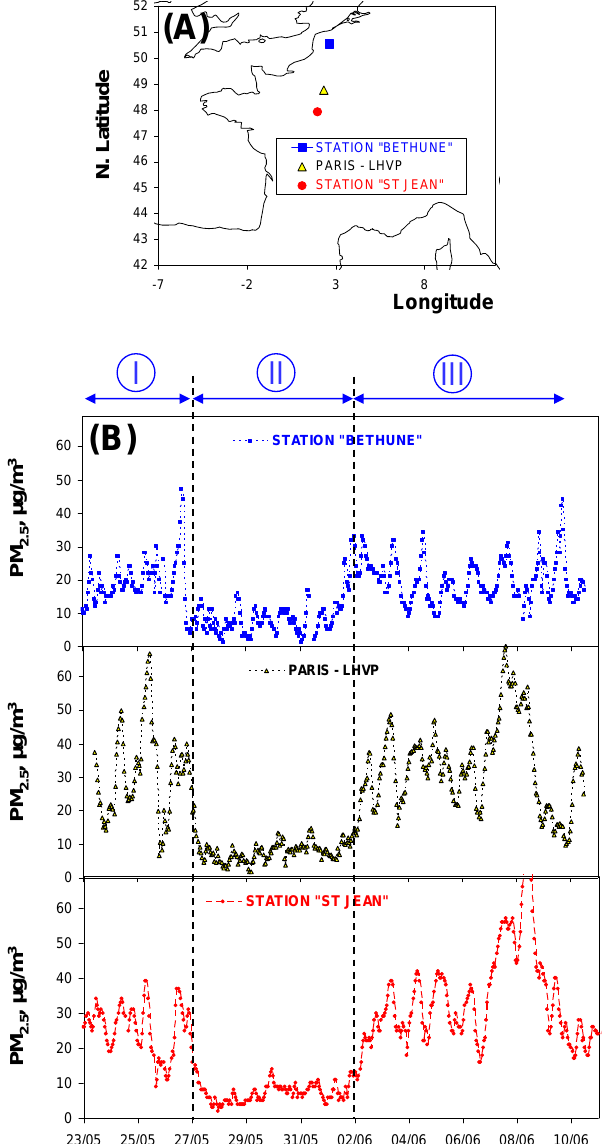
Fig. 7. (A) Location of 3 ground stations with PM 2 . 5 (TEOM- FDMS) measurements in the neighboring regions of Paris. (B) Tem- poral variation of PM 2 . 5 at these 3 stations. Periods noted I, II, and III correspond to those reported in Sect.